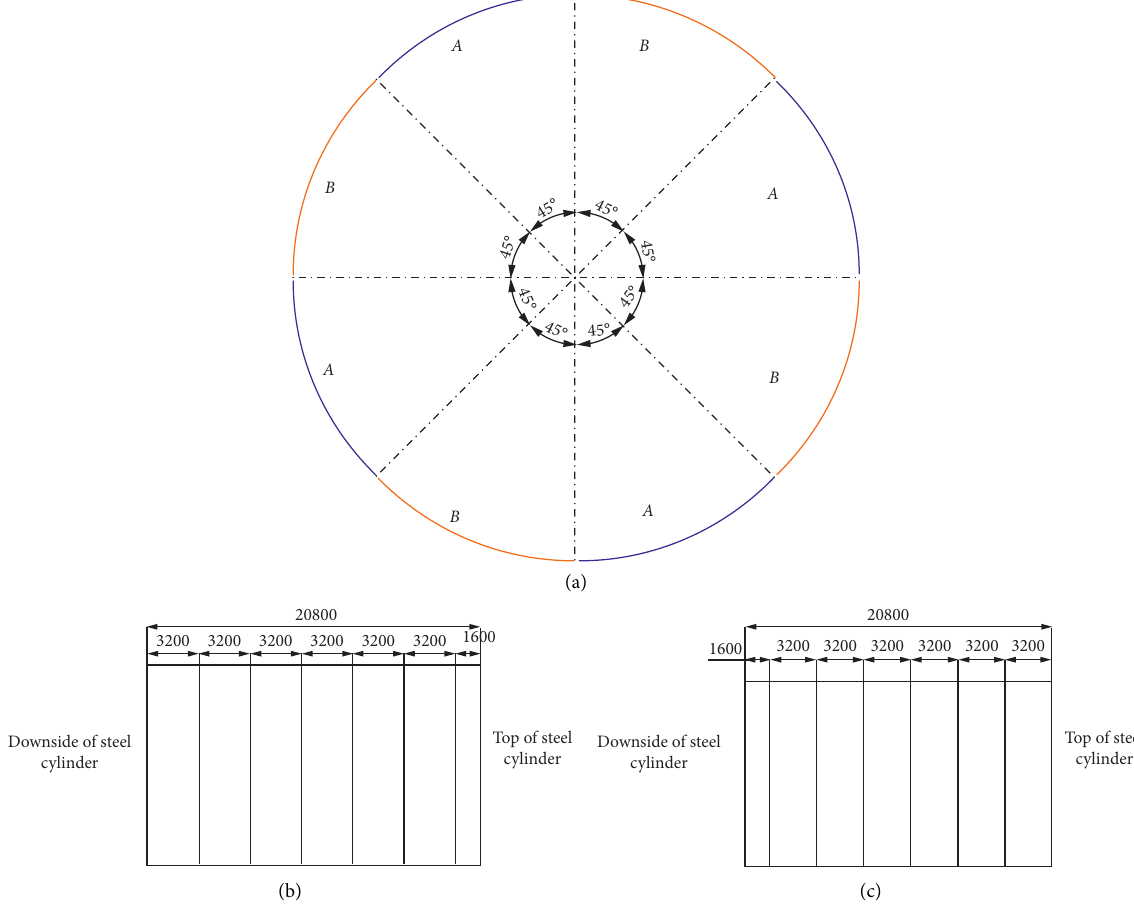
Figure 9: Lower section segments: (a) section segments (top view); (b) type A cylinder design (side view); (c) type B cylinder design (side